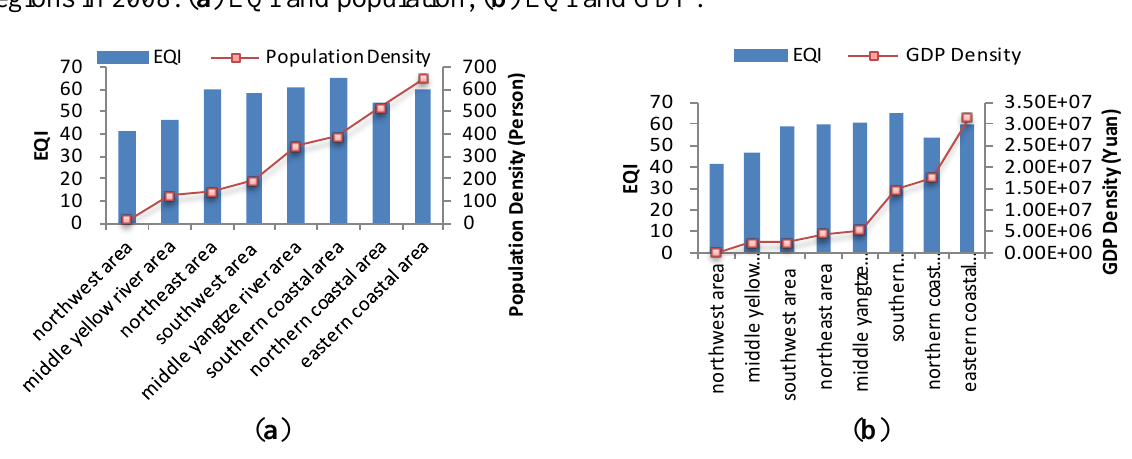
Figure 14. Relationship between EQI, population and GDP density in eight economic regions in 2008. ( a ) EQI and population; ( b ) EQI and GDP.